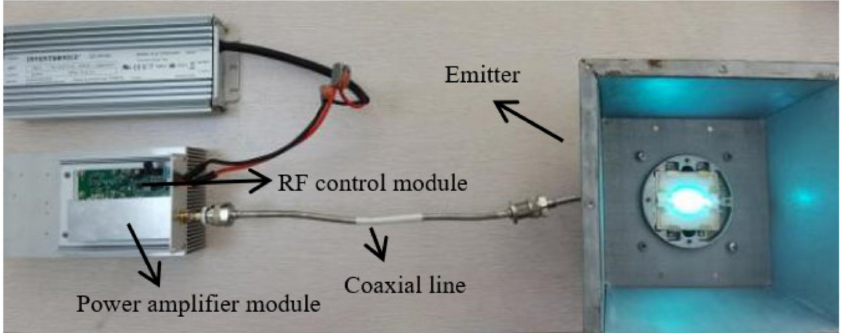
Figure 9. The microwave plasma light source system.